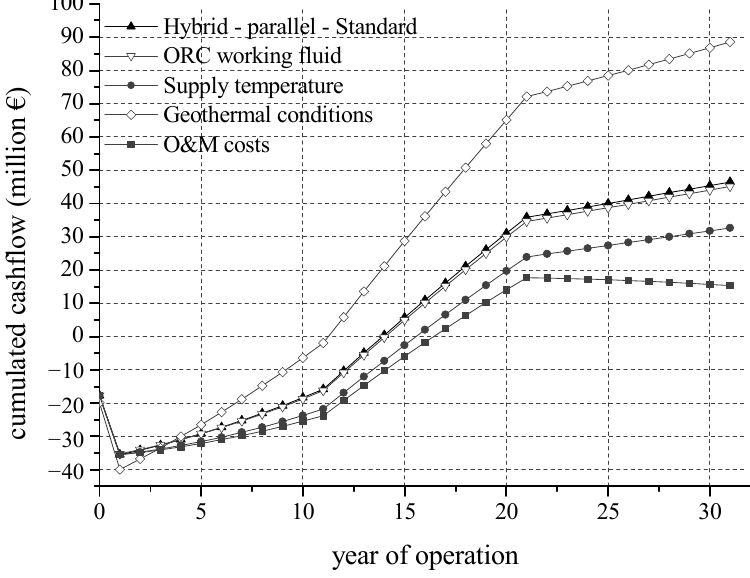
Figure 12. Cumulated cashflow for the variable boundary